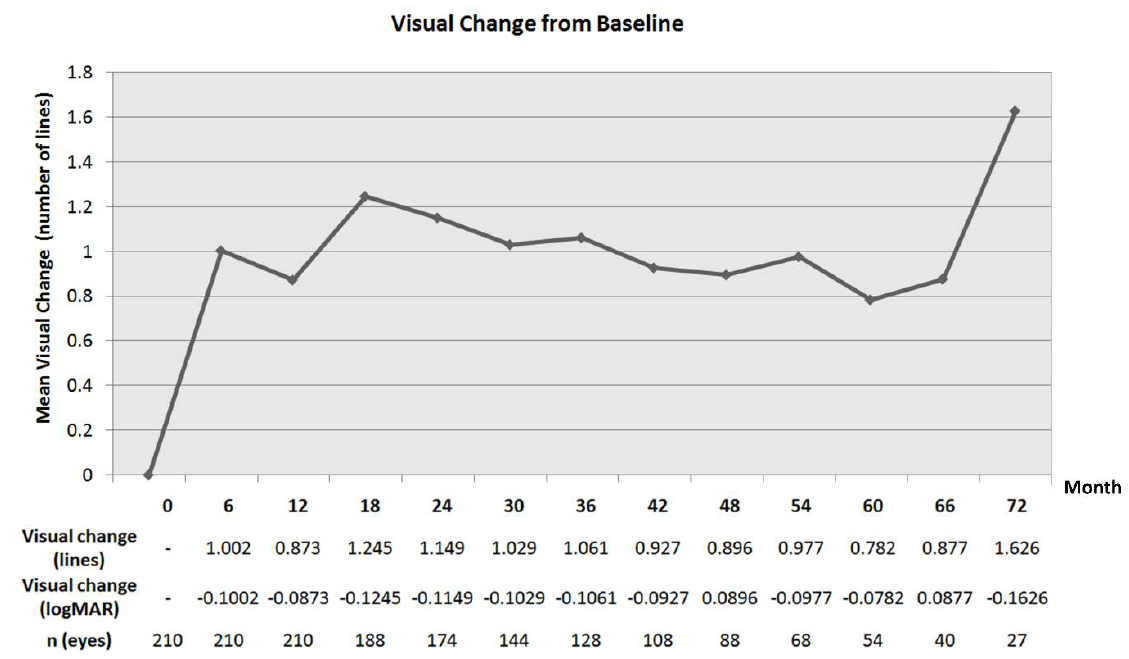
Figure 1. Mean visual acuity over time. The visual acuity is noted in logMAR and Snellen chart, as well as the number of eyes at each time point.